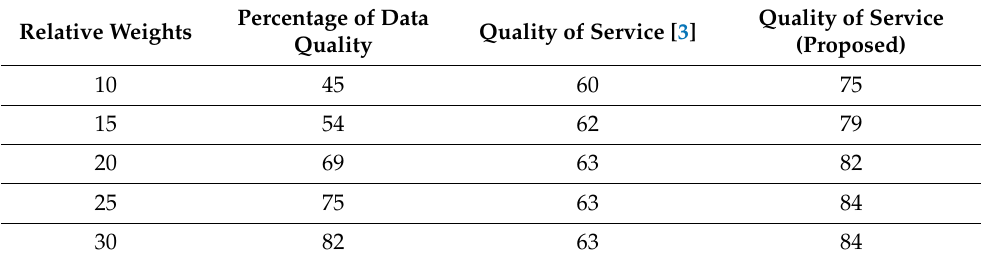
Table 7. Quality of service with a relative weighting